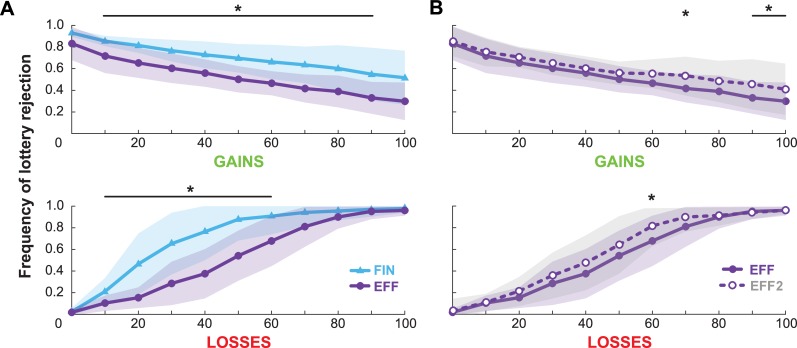
Frequency of rejecting lotteries.Comparison of mean and standard deviation of lottery rejection for (A) EFF and FIN tasks. and (B) EFF and EFF2 tasks. In all tasks, the frequency of rejection decreases with larger gains and increases with larger losses. Asterisks (*) span across gain/loss values for which there is a significant difference between the two compared tasks.